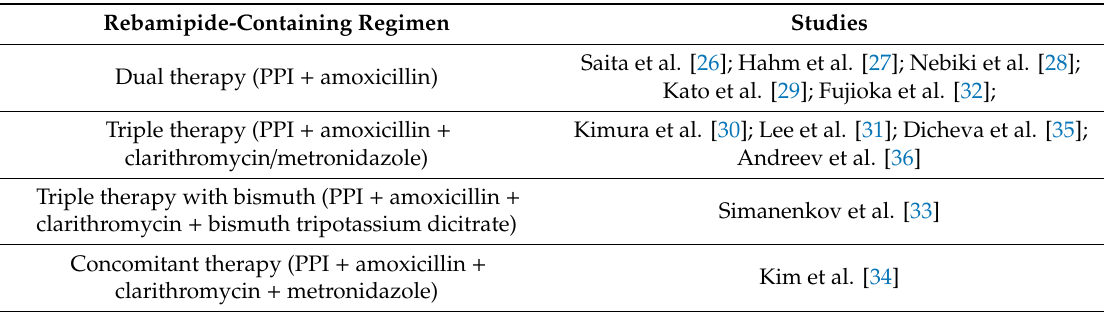
Table 3. Analysis of selected studies on the administered regimens with the inclusion of